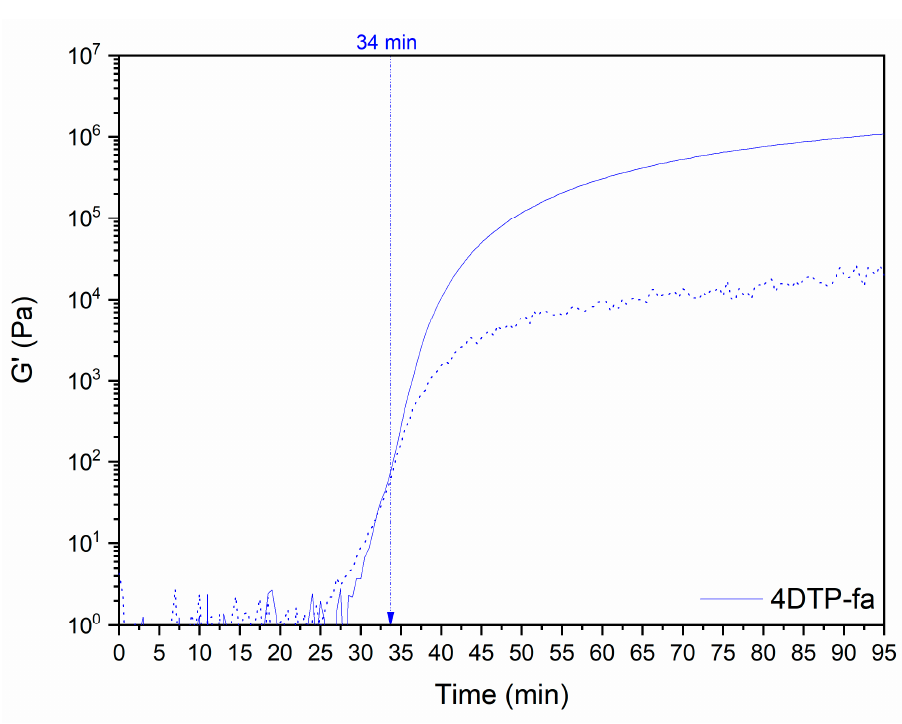
Figure A18. Curing behavior of 4DTP-fa by rheo-kinetics measurement at 150 °C over time. Full line storage modulus (G’) and dash line (G’’). Gelation points are indicated by dotted lines with arrows.